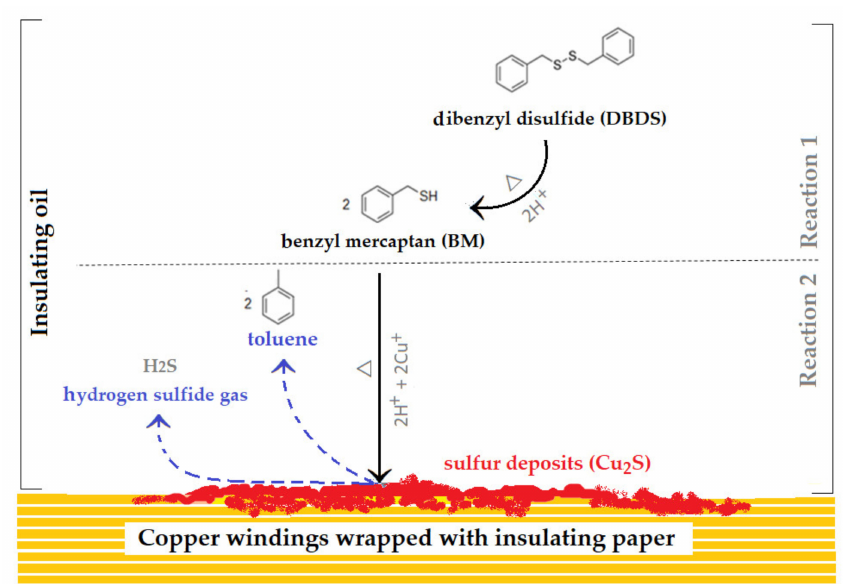
Figure 2. Mechanism of corrosion reaction [3]. The copper sulfide deposits on the insulating papers can form a low-resistance path throughout the layers of the papers and migrate onto the surface of the copper winding